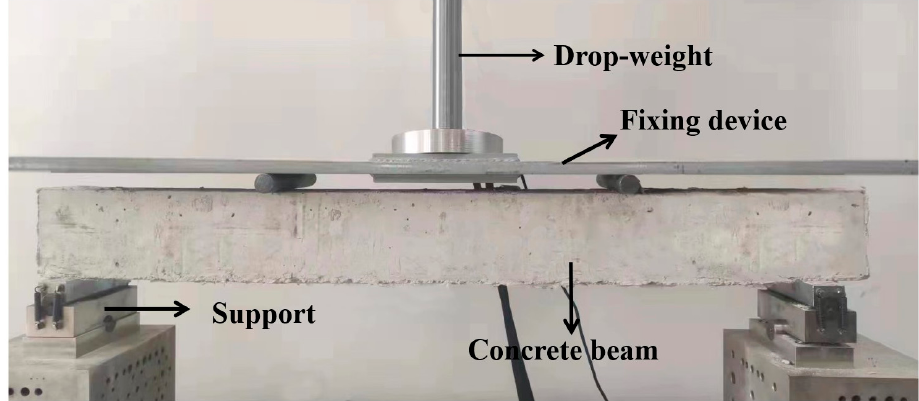
Figure 3. The test process and loading mode of the impact test.